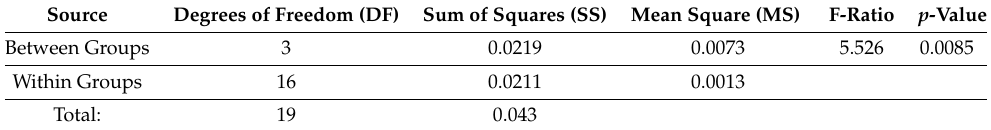
Table 9. ANOVA source table for F 1 scores of the drone experiment with outliers in the training